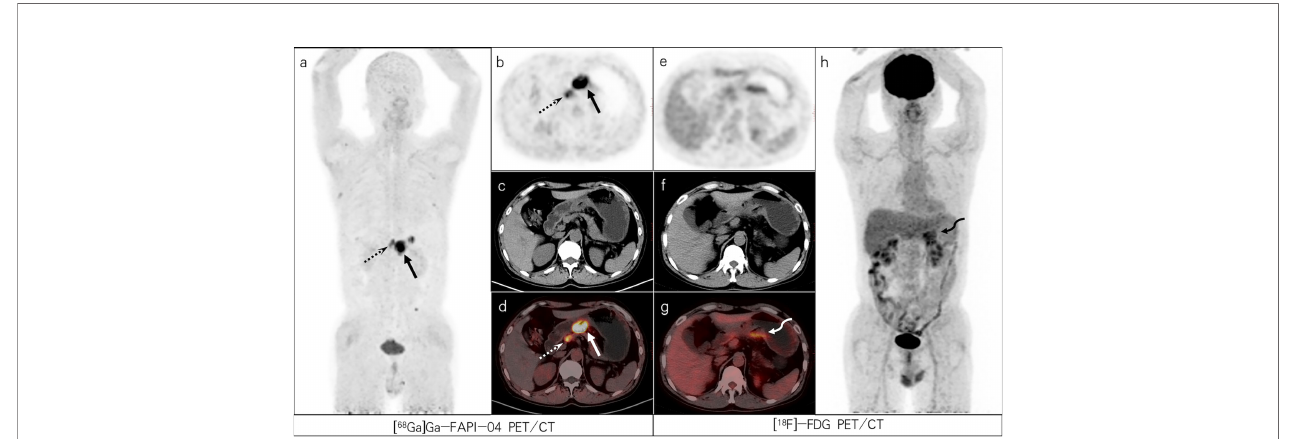
FIGURE 5 | A 56-year-old male patient with poorly differentiated gastric adenocarcinoma based on pathological biopsy under gastroscopy. [ 68 Ga]Ga-FAPI-04 PET/ CT (A – D) revealed high uptake in the primary tumor (slender arrows, SUVmax=14.6) and lesser curved lymph nodes of the stomach (dashed arrows, SUVmax=8.7), but moderate uptake in the primary tumor (bent arrows, SUVmax=5.3) and negative uptake of lesser curved lymph nodes of the stomach were observed on [ 18 F]- FDG PET/CT (E – H)